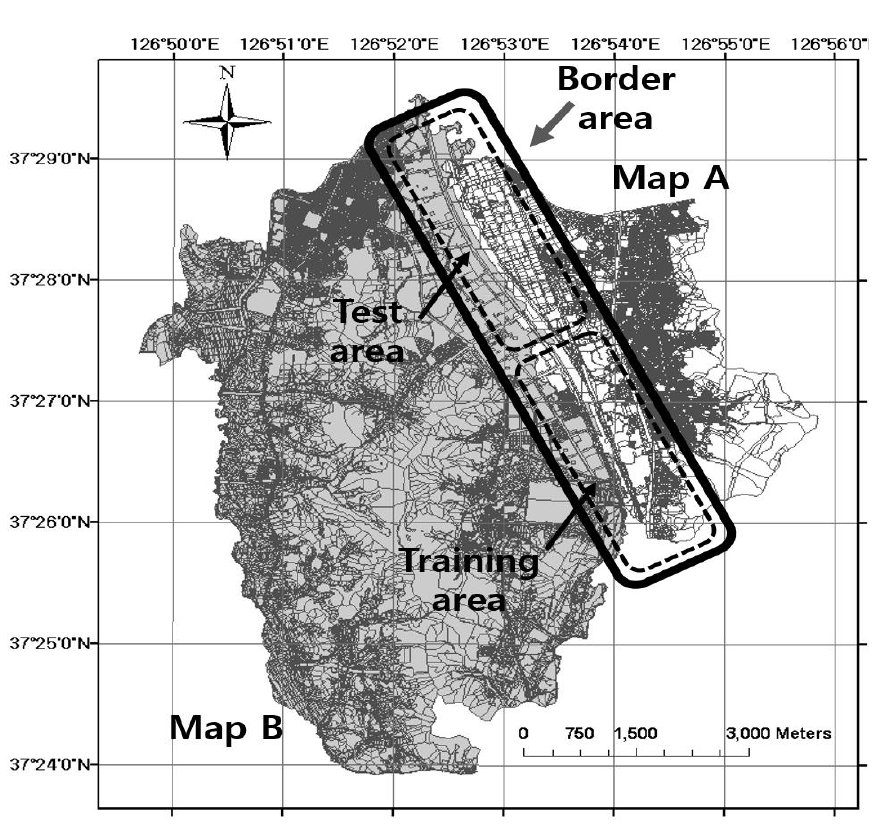
Figure 9. Two adjacent cadastral maps (map A and map B) for the experiments.